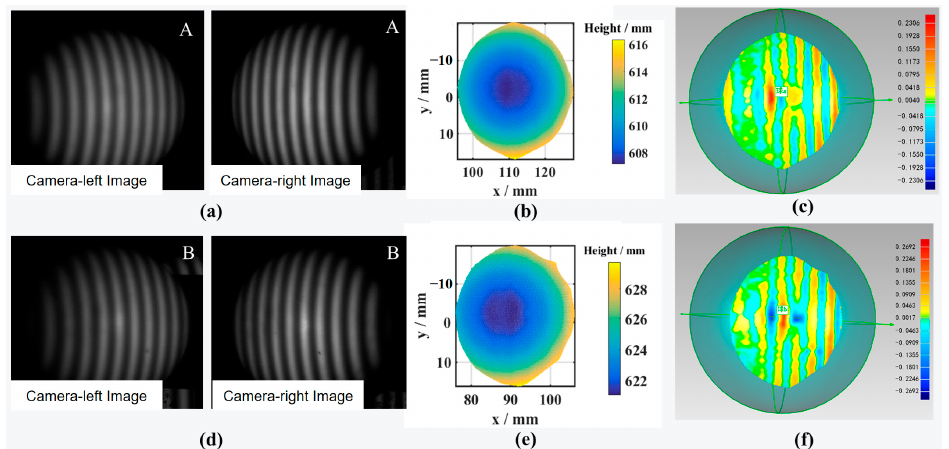
Figure 10. Measurement results of the ball-bar gauge standard part, ( a ) deformation fringe image measured on ball A; ( b ) height distribution of ball A; ( c ) standard deviation distribution of ball A; ( d ) deformation fringe image measured for ball B; ( e ) height distribution of ball B; ( f ) standard deviation distribution of ball B. Table 1. Accuracy evaluation results of dumbbell gauge standard parts (unit: mm). Ball-Bar Gauge Standard